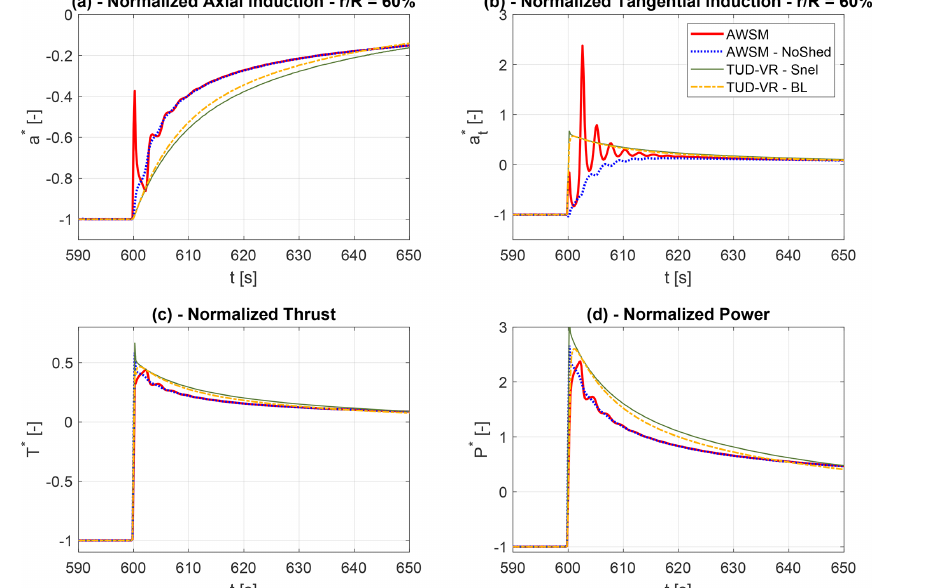
Figure 5. Zoomed-in view of the time interval near the loading step to highlight the effect of shed vorticity in the time history of (a) the normalized axial induction at 60% span, (b) the normalized tangential induction at 60% span, (c) the normalized aerodynamic thrust, and (d) the normalized aerodynamic